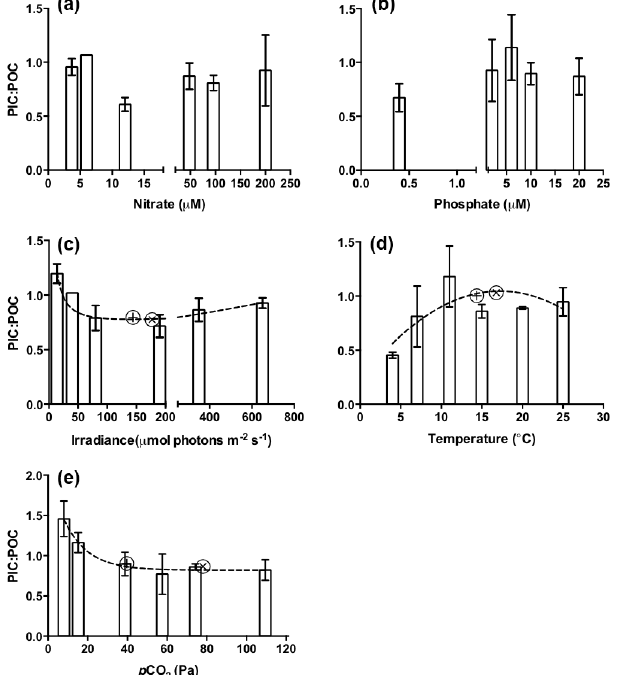
Figure 4. Changes in Emiliania huxleyi cellular particulate or- ganic nitrogen (PON) content in response to different environmen- tal drivers: (a) cellular PON vs. nitrate concentration, (b) cellular PON vs. phosphate concentration, (c) cellular PON vs. irradiance, (d) cellular PON vs. temperature, and (e) cellular PON vs. p CO 2 .